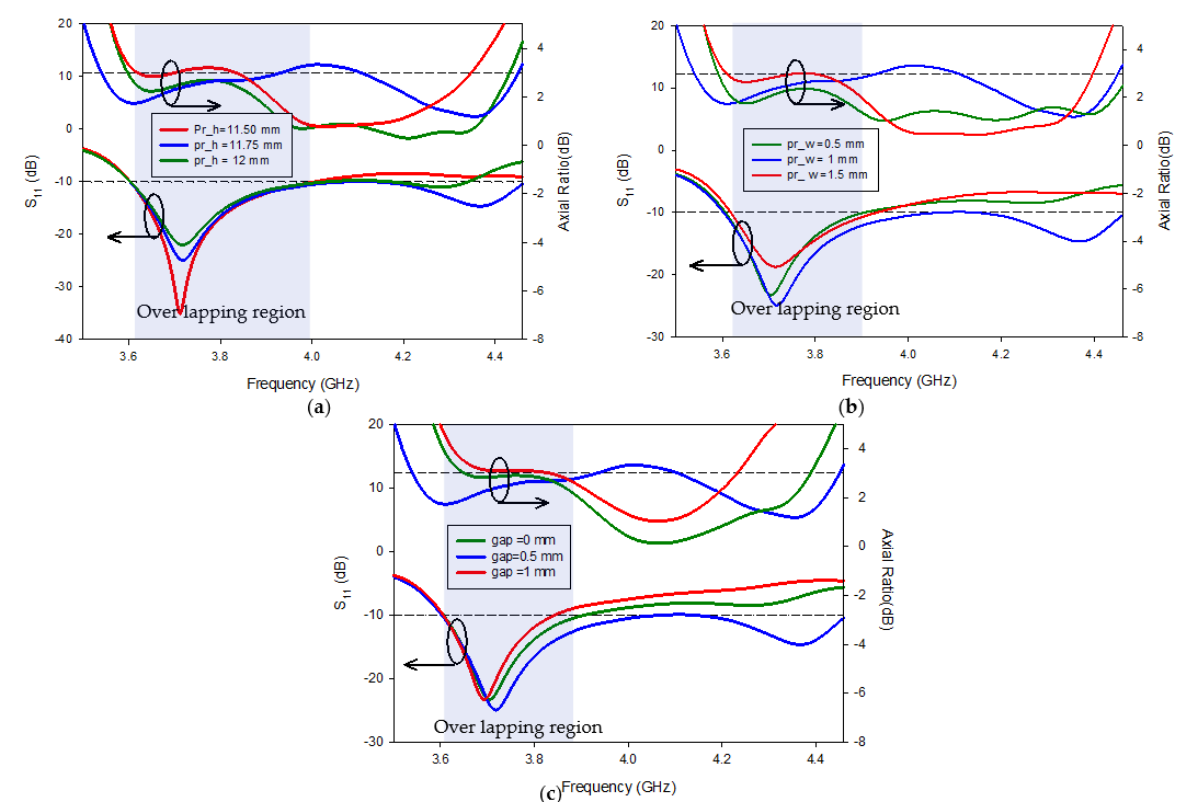
Figure 6. Parametric examination of return loss and axial ratio for various: ( a ) Height, ( b ) width, and ( c ) positions of the parasitic strip.